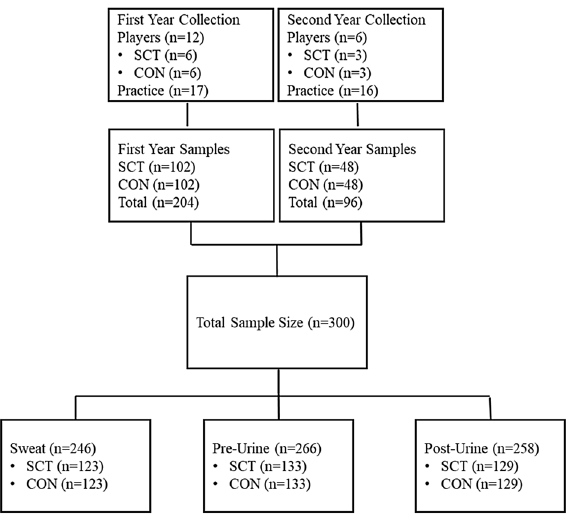
Figure 2. The total hydration samples were collected and pooled across practices by